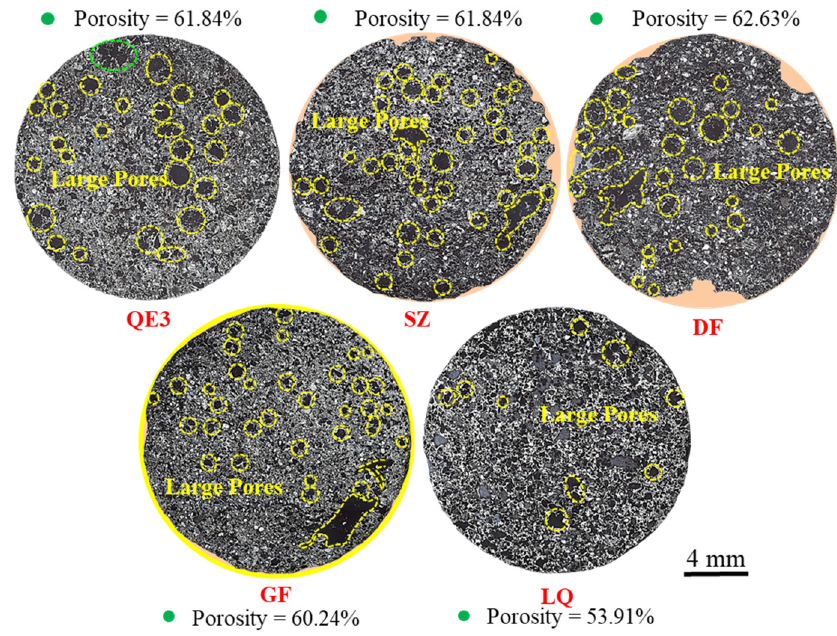
Figure 12. Panorama of ferro-coke on cross-section with different binders.